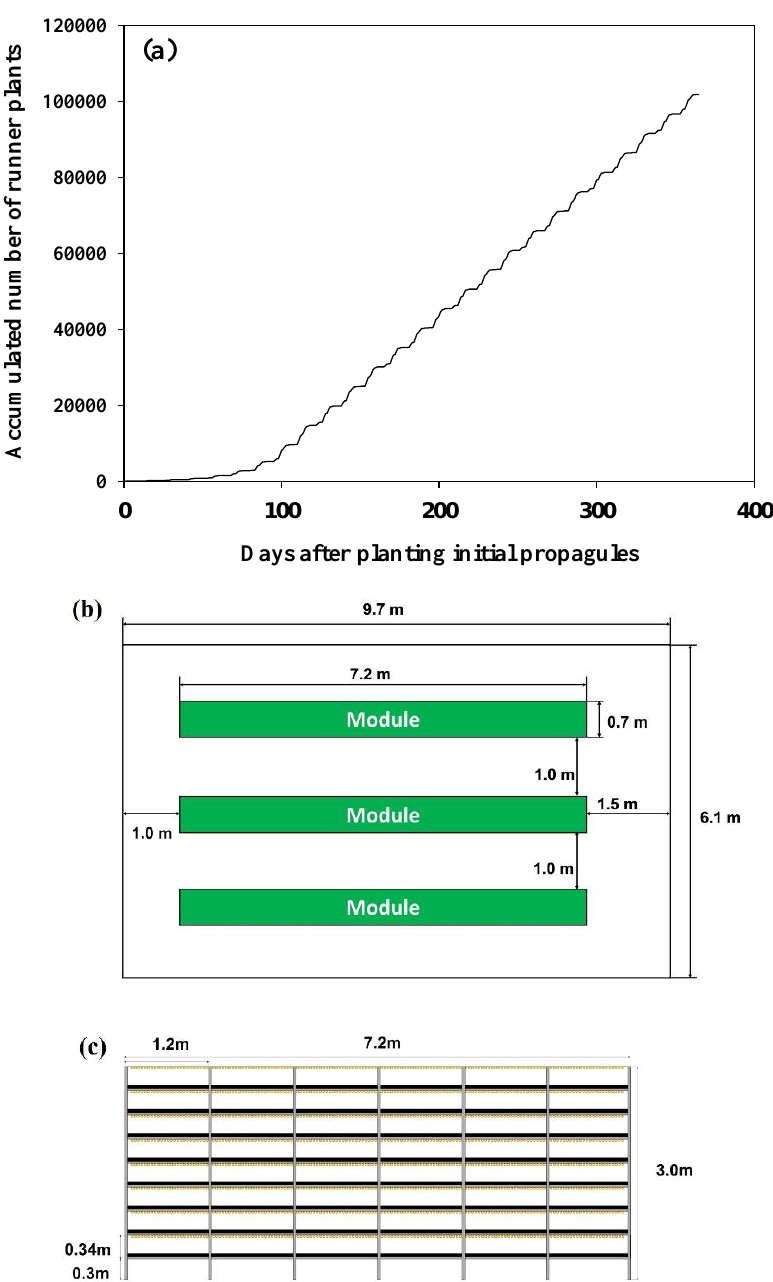
Figure 7. Time courses of cumulated numbers of runner plants simulated by a program to predict number of transplants for autotrophic transplant production method in a plant factory using artificial lighting ( a ). The result was simulated by propagation area 115 m 2 to produce 100,000 runner plants from 100 initial propagules for a year. Floor plan of a T-PFAL ( b ) and a side view of a module in the T-PFAL ( c ) for production of 100,000 runner plants by ATPM.